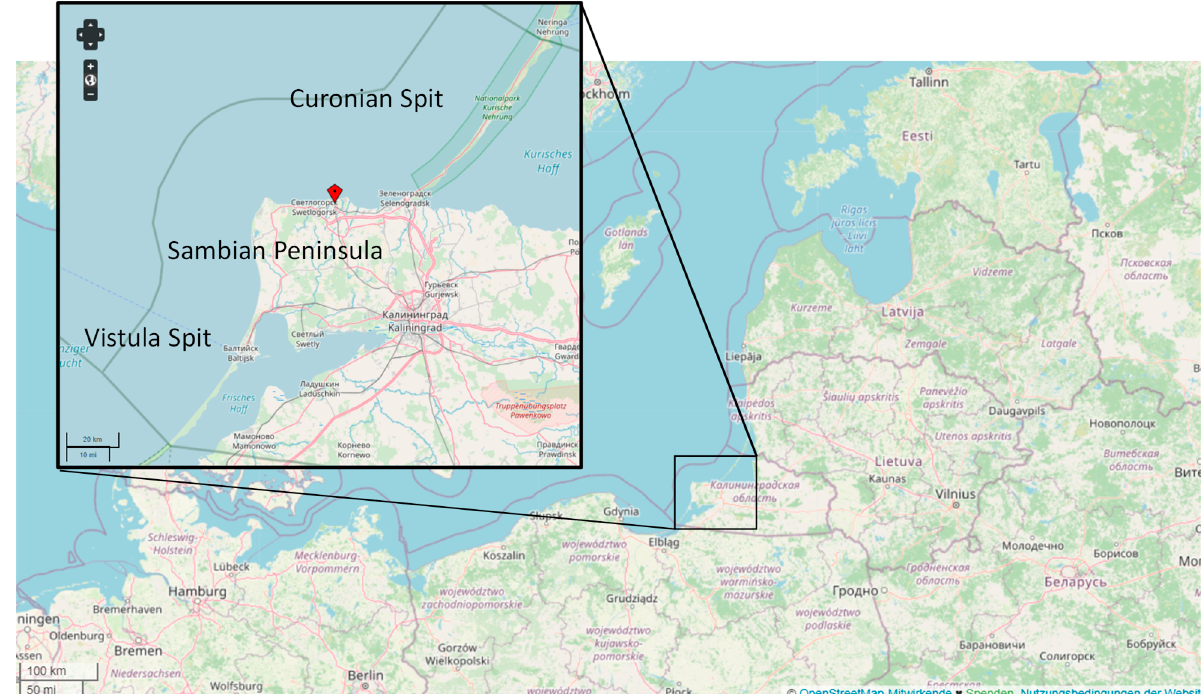
Figure 2. Shoreline of the Kaliningrad Oblast (Russia) in the Baltic Sea including the Sambian Peninsula (quadrangle). Source: OpenStreetMap.